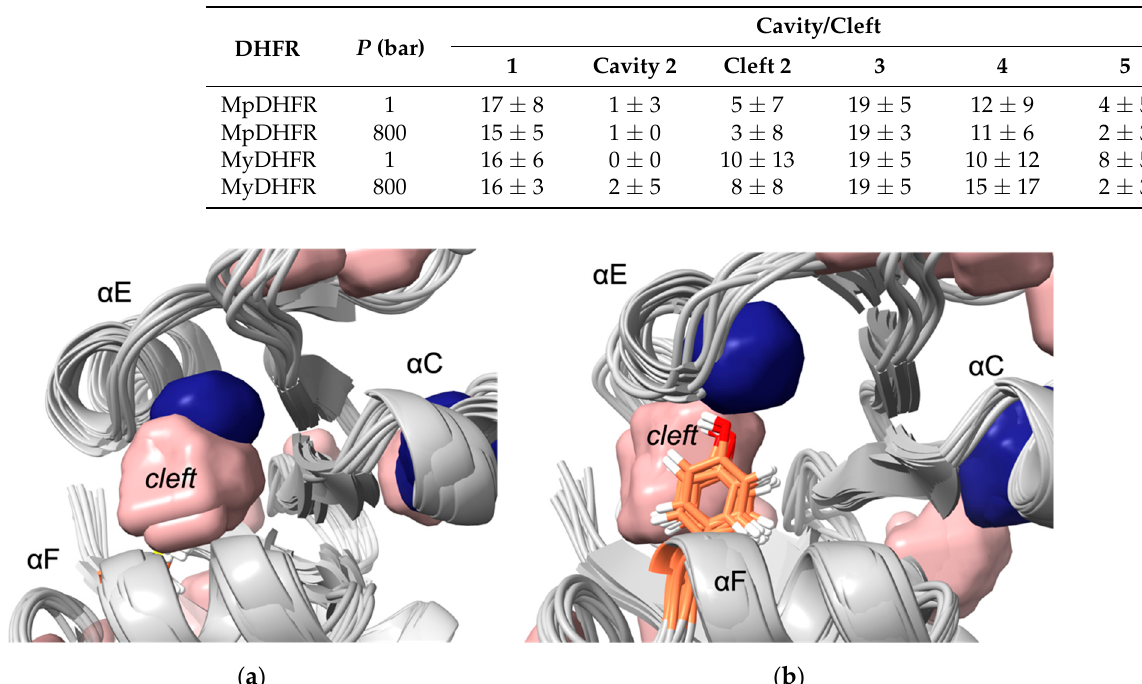
Figure 4. Cavity 2 and cleft 2 near Res103. ( a ) Cavity 2 (dark blue) and solvent-accessible cleft 2 (pink) along helix E across from Cys103 in MpDHFR merge at 800 bar, providing solvent access to the internal cavity. ( b ) Cleft 2 remains separated from cavity 2 by Tyr103 (orange) in MyDHFR, possibly preventing solvent penetration into the cavity.